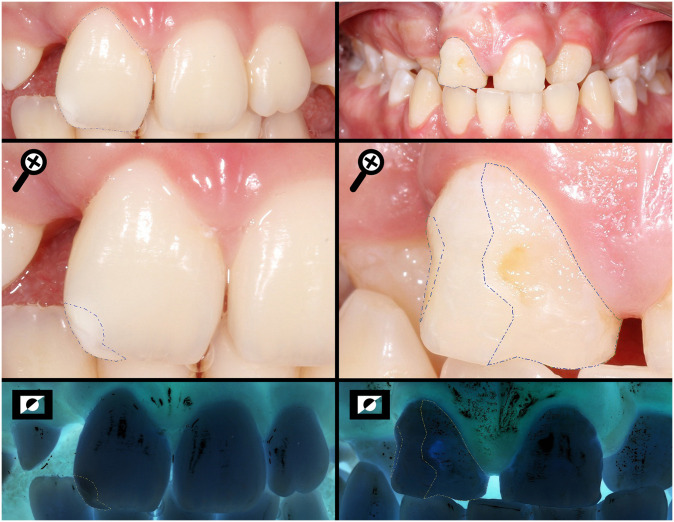
Measuring the total area of the buccal surface (SA) and the areas of the enamel defects found (DA) of a UCLP and BCLP individuals, respectively, using the negative photo as a tool to help to limit the extension.